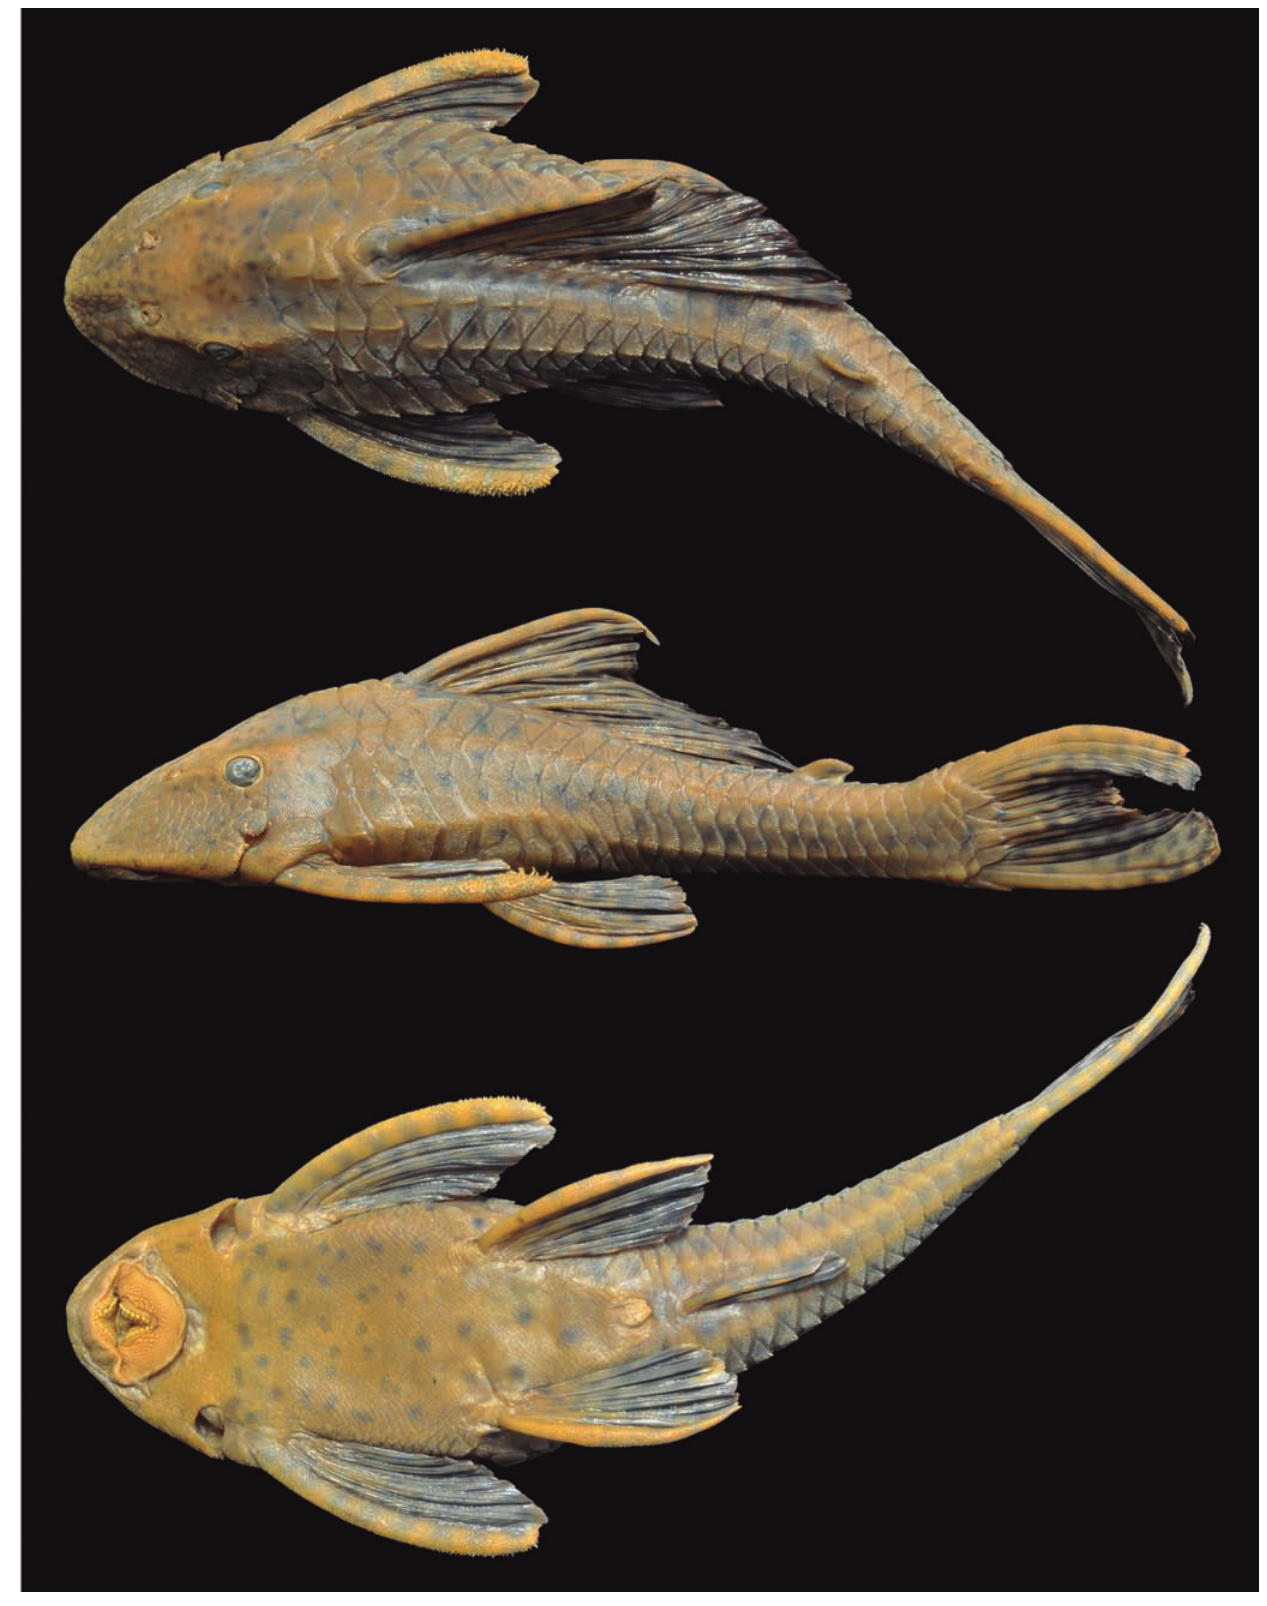
Fig. 2. Hypostomus cochliodon , NUP 10807, 208.0 mm SL; dorsal (top), lateral (middle), and ventral (bottom)